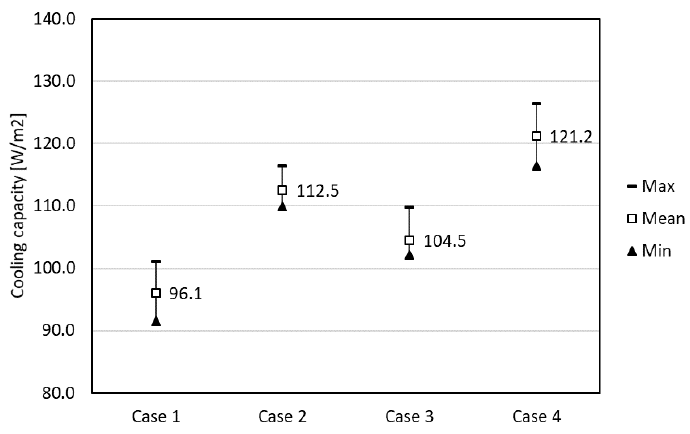
Figure 5. Measurement result of cooling capacity for different cases.